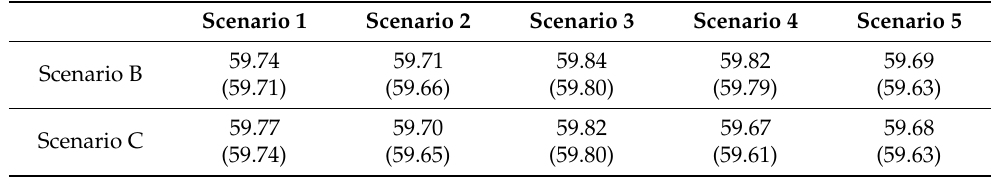
Figure 16. ESS operation strategy.